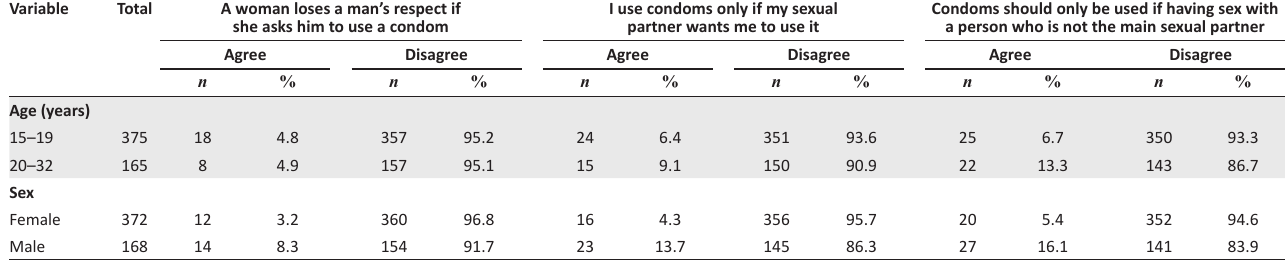
TABLE 4b: Student’s attitudes related to condom use.